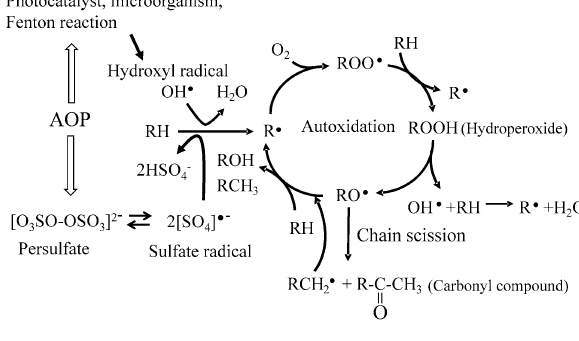
Fig. 4 Autoxidation mechanism initiated by advanced oxidation process